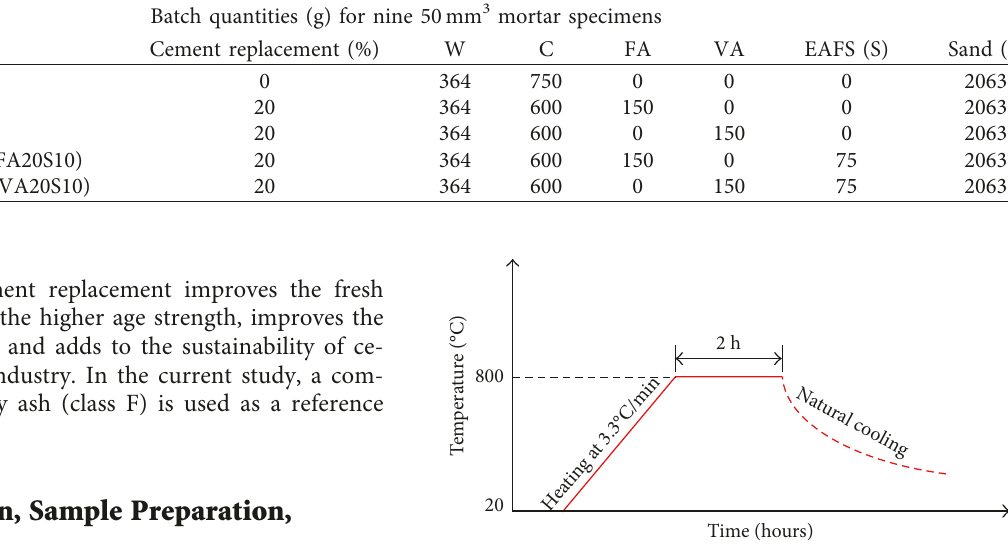
Figure 1: The time-temperature curve of the furnace for heat exposure.